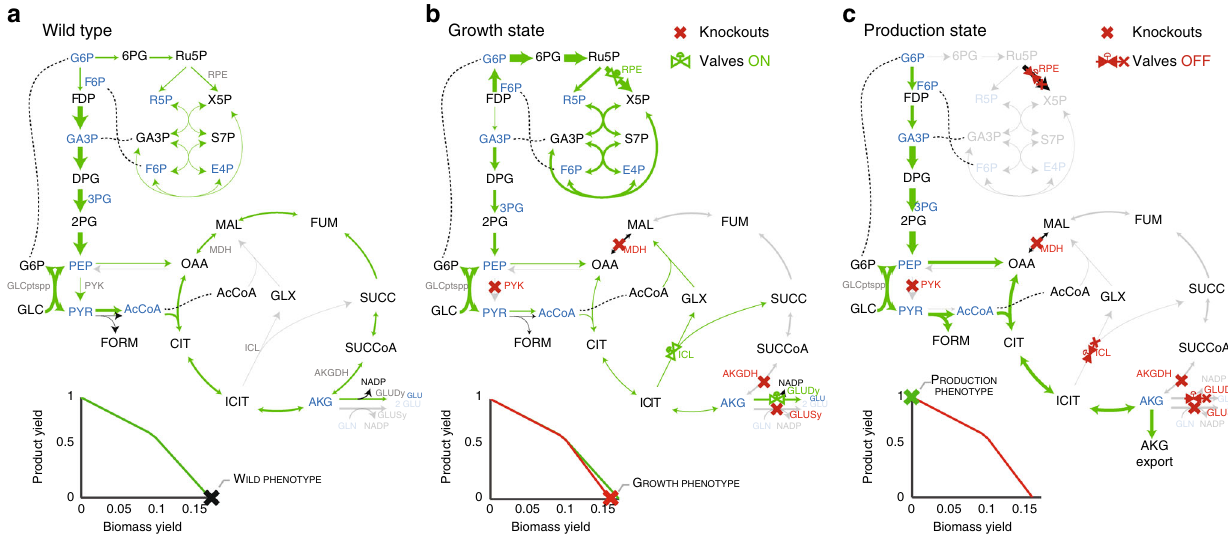
Fig. 3 Application of MoVE to a core model for α -ketoglutarate (AKG) production. Line thickness is proportional to pathway fl ux, metabolites highlighted in blue are biomass precursors. a Wild-type fl ux distribution of the E. coli core model. Aerobically grown wild-type E. coli is known to partition fl ux between glycolysis and the pentose phosphate pathway, with a fully active tricarboxylic acid (TCA) cycle and respiratory chain 56 , leading to maximal biomass yield and growth rate. b Flux-distribution with identi fi ed knockouts applied. Following knockout of the predicted reactions and associated genes: pyruvate kinase (PYK, pykAF ), succinyl-CoA synthetase (SUCOAS, sucA ), glutamate synthase (GLUSy, gltB ), and malate dehydrogenase (MDH, mdh ), fl ux is